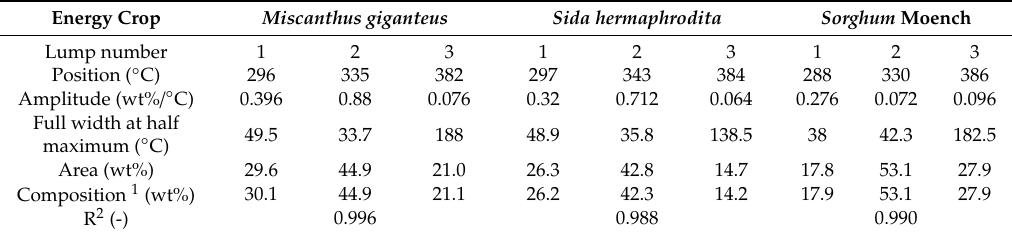
Table 2. Parameters of deconvolution of DTG curves for energy